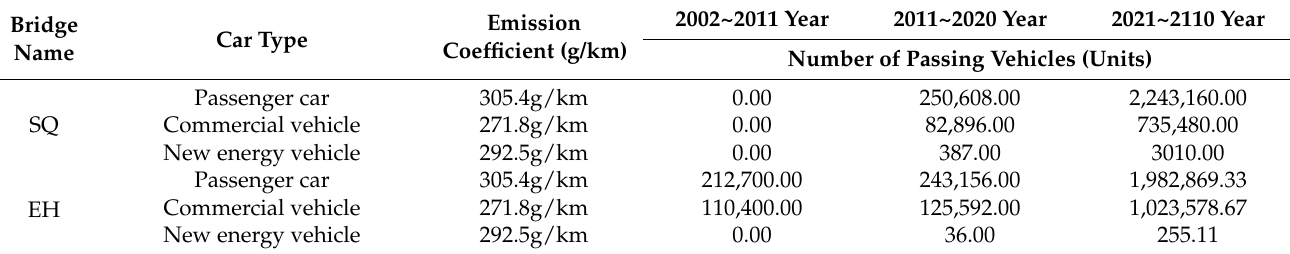
Table 8. Summary table of assessment vehicle data analysis for SQ and